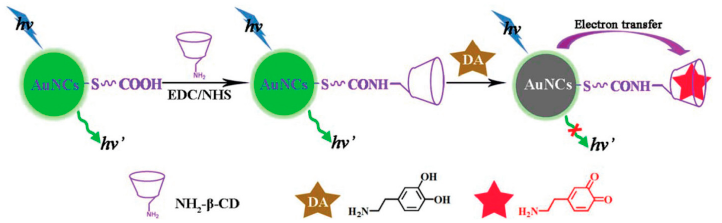
Figure 7. Schematic illustration of the analytical strategy for dopamine detection. Adapted with permission from Reference [68] Copyright (2015) Royal Chemistry Society.